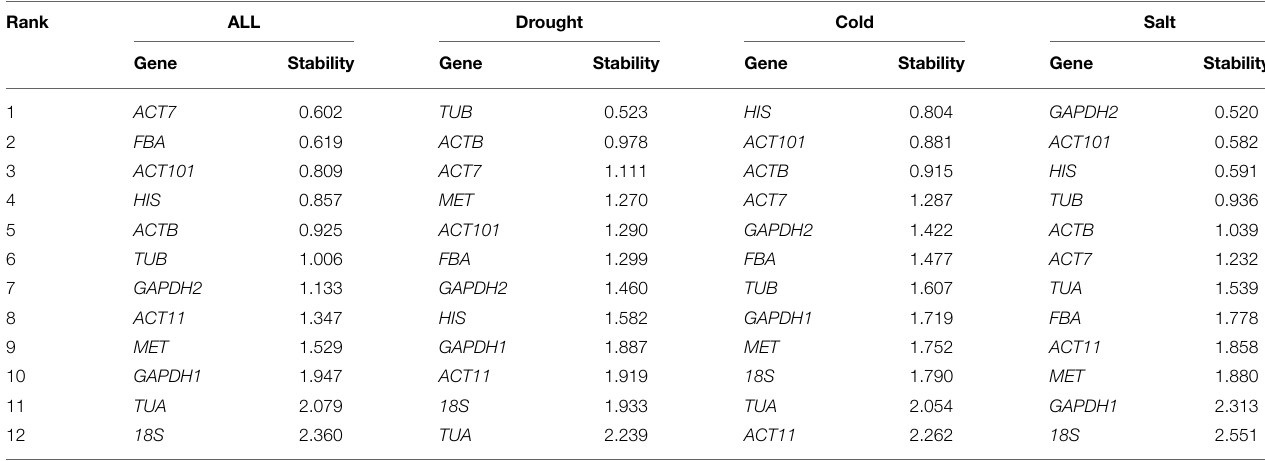
Lower expression stability value indicates more stable